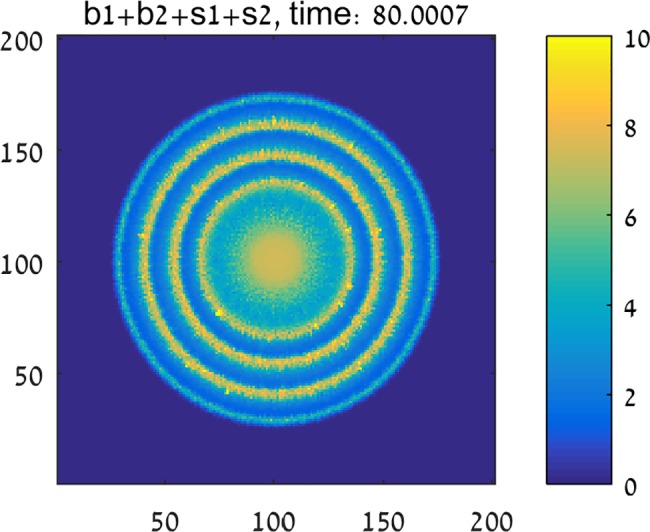
Two-species simulations.The joint P. vortex and E. coli bacterial colony in an antibiotic environment develops ring-like patterns. All simulation parameters are the same as in Fig 3.